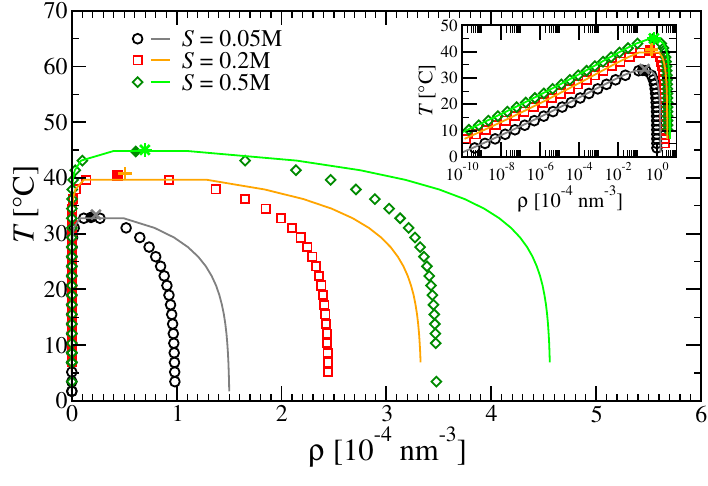
Figure 6. Main panel: Coexistence regions in the T – ρ plane for tetramers at different salt concentrations. Symbols and lines refer to data obtained with second-order virial approximation (full lines) and third-order virial approximation (open symbols); full symbols refer to critical points. Inset: As in main panel, semi-log scale emphasizes the low-density